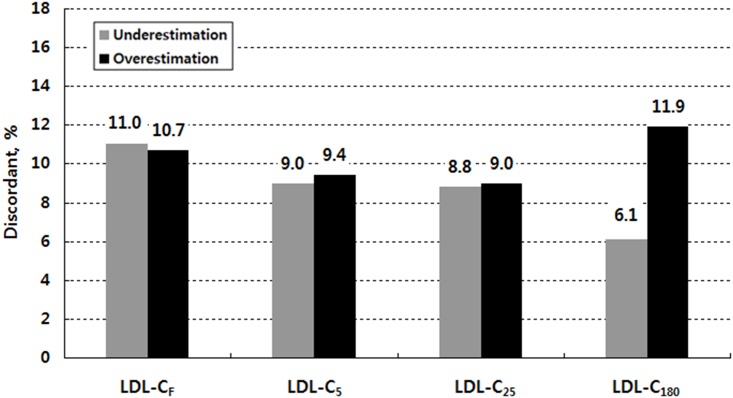
Overall discordance (underestimation vs. overestimation) in the NCEP-ATP III guideline classification by low-density lipoprotein cholesterol (LDL-C) estimate when triglycerides are lower than 400 mg/dL.LDL-C indicates low-density lipoprotein cholesterol; LDL-CF, Friedewald LDL-C; LDL-C5, 5-cell method LDL-C; LDL-C25, 25-cell method LDL-C; LDL-C180, 180-cell method LDL-C (Martin et al. [9])